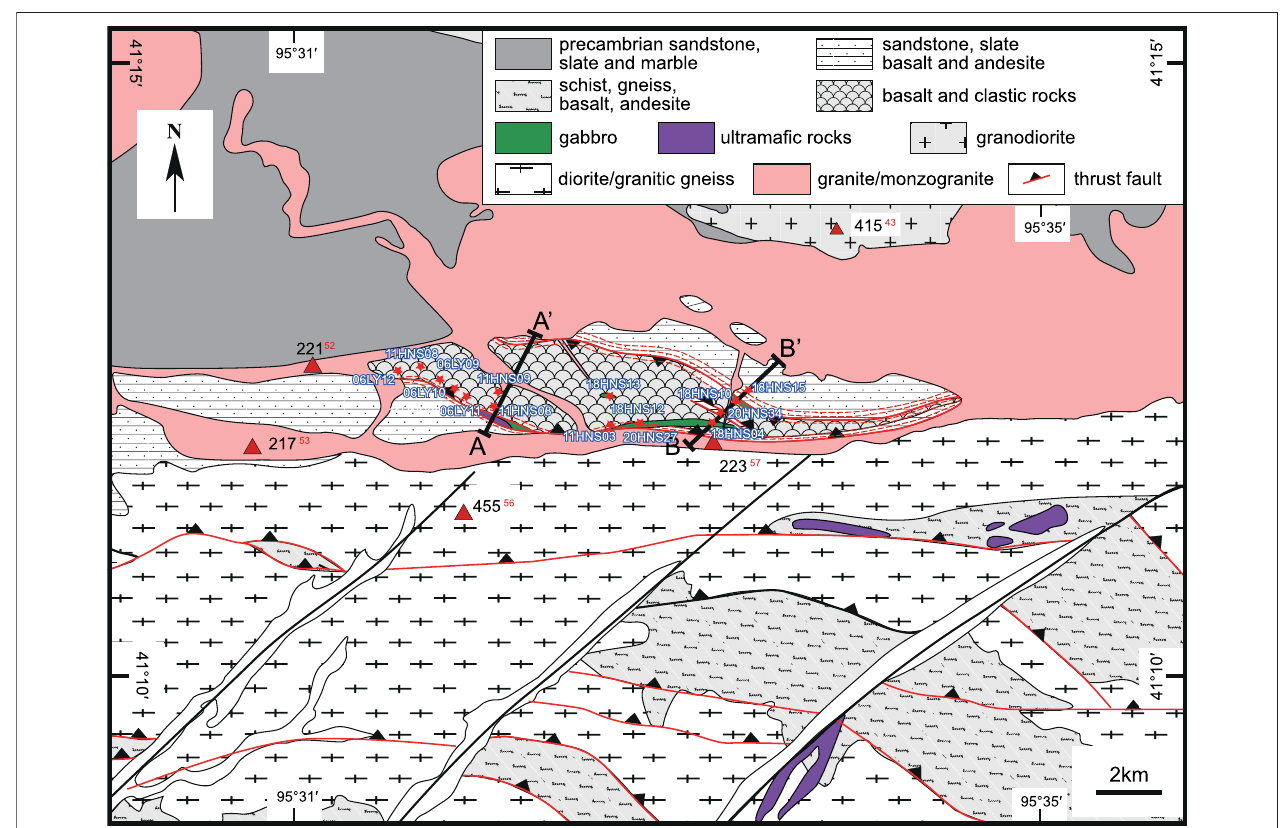
FIGURE 2 | Geological map of the Huaniushan complex in the northern part of the Liuyuan accretionary complex.